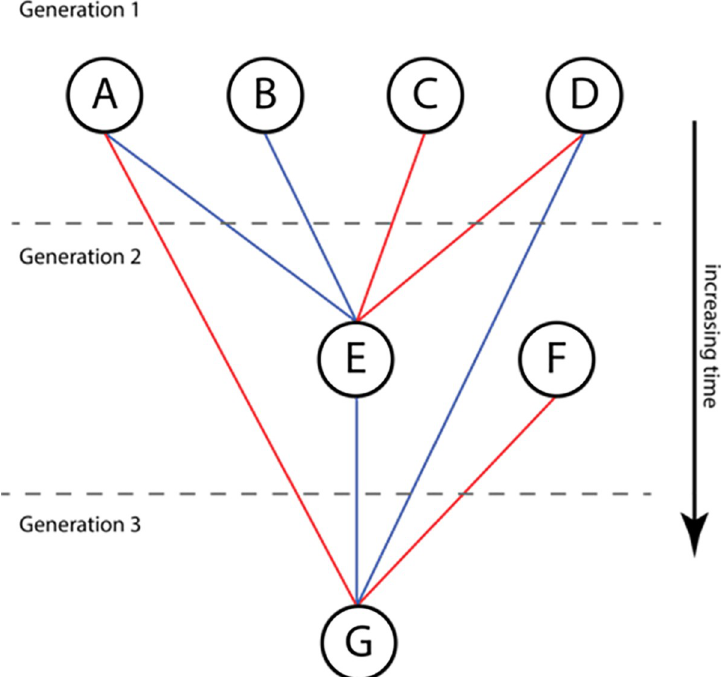
Fig 1. Simple model for academic hierarchy involving both supervisor-student links and examiner-examinee links. Red lines represent examination relationships and blue lines represent supervisor/advisor relationships. In this diagram, A and B supervise E, who is examined by C and D; E then supervises G with D, who is in turn examined by A and F.